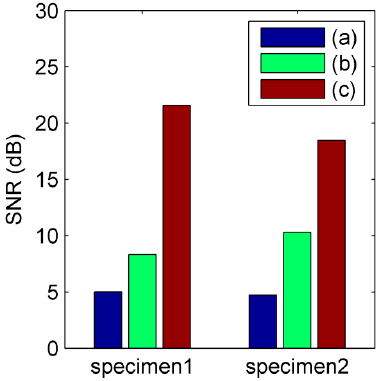
Figure 13. The comparison of signal-to-noise ratio (SNR) for different specimens: ( a ) Conventional TFM; ( b ) TFM with hybrid full matrix; ( c ) SCF with the hybrid full matrix.